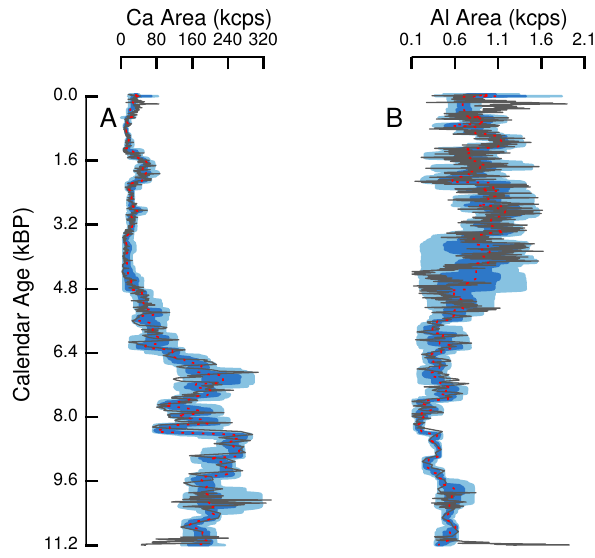
Figure 7. Comparison of results with OxCal. The proxy records es- timated by the present approach (red, dotted) compared to proxy Fig. 7. Comparison of results with OxCal. The proxy records es- records obtained by using an OxCal P -sequence age model (dark timated by the present approach (red, dotted) compared to proxy gray) for the groundwater inflow (Ca-area, a ) and surface erosion records obtained by using an OxCal P-sequence age model (dark (Al-area, b ) proxies from the Lonar lake. The legend for the con- fidence bounds to the Bayesian proxy estimate is the same as in gray) for the groundwater inflow (Ca area, A ) and surface erosion Fig. 6d and f. (Color (Al area, B ) proxies from Lonar lake. Legend for the confidence bounds to the Bayesian proxy estimate is same as in Fig. 6, panels D and F . (Color online.)